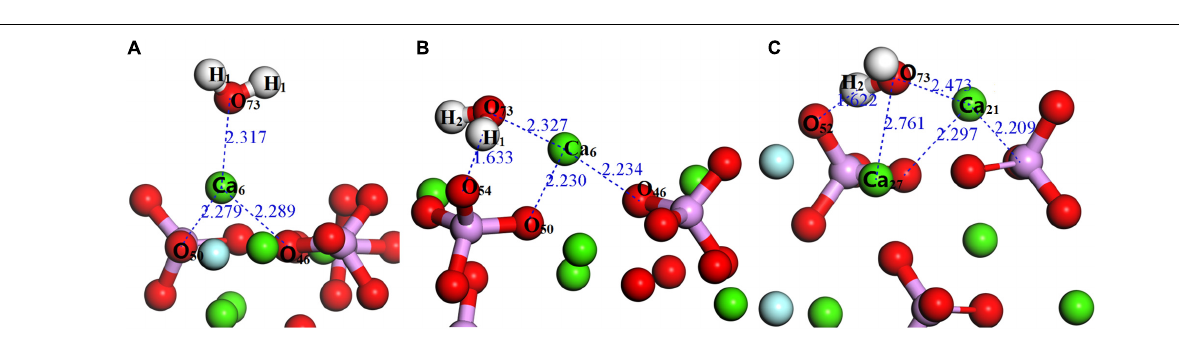
Frontiers in Materials |